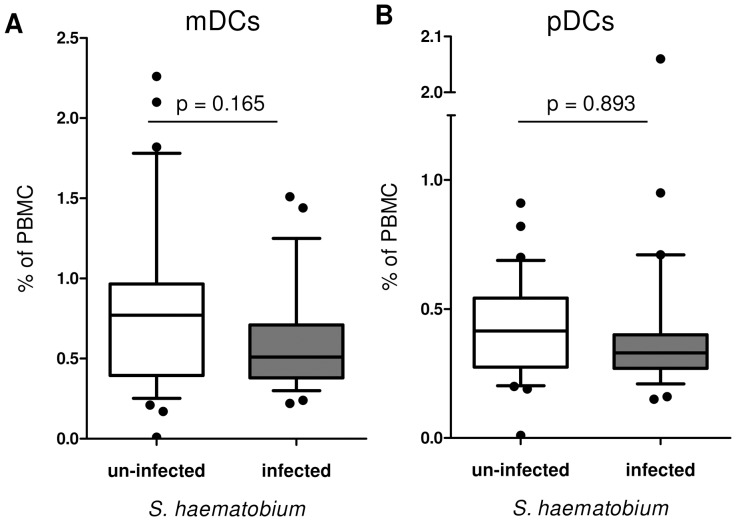
Proportions of DCs in the study population.PBMC (N = 61) were analysed for proportions of (A) CD123neg/lowCD11c+ mDCs or (B) CD123hiCD11cneg pDCs (expressed as % of PBMC). Data of the total population were divided in un-infected (N = 32, white box) and infected individuals (N = 29, gray box). Data are presented as Whiskers boxplot (10–90 percentiles). Differences were analysed by univariate analysis after accounting for the effect of sex.